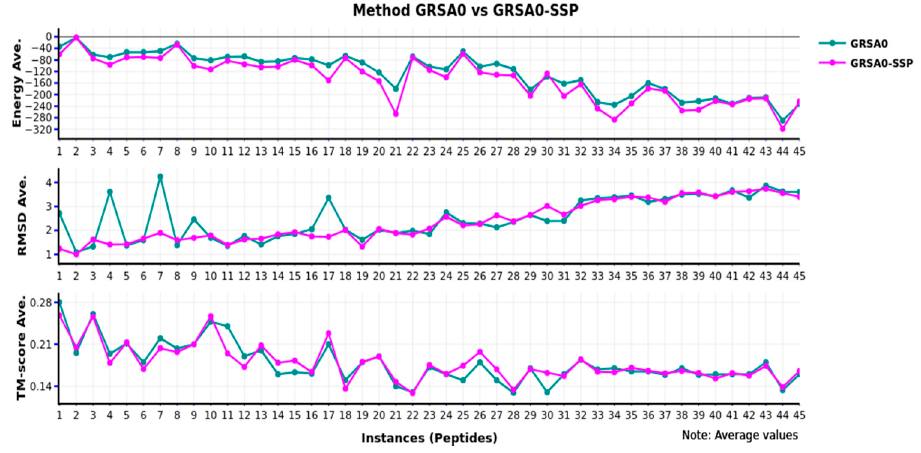
Figure 2. Comparison of GRSA0 versus GRSA0-SSP.